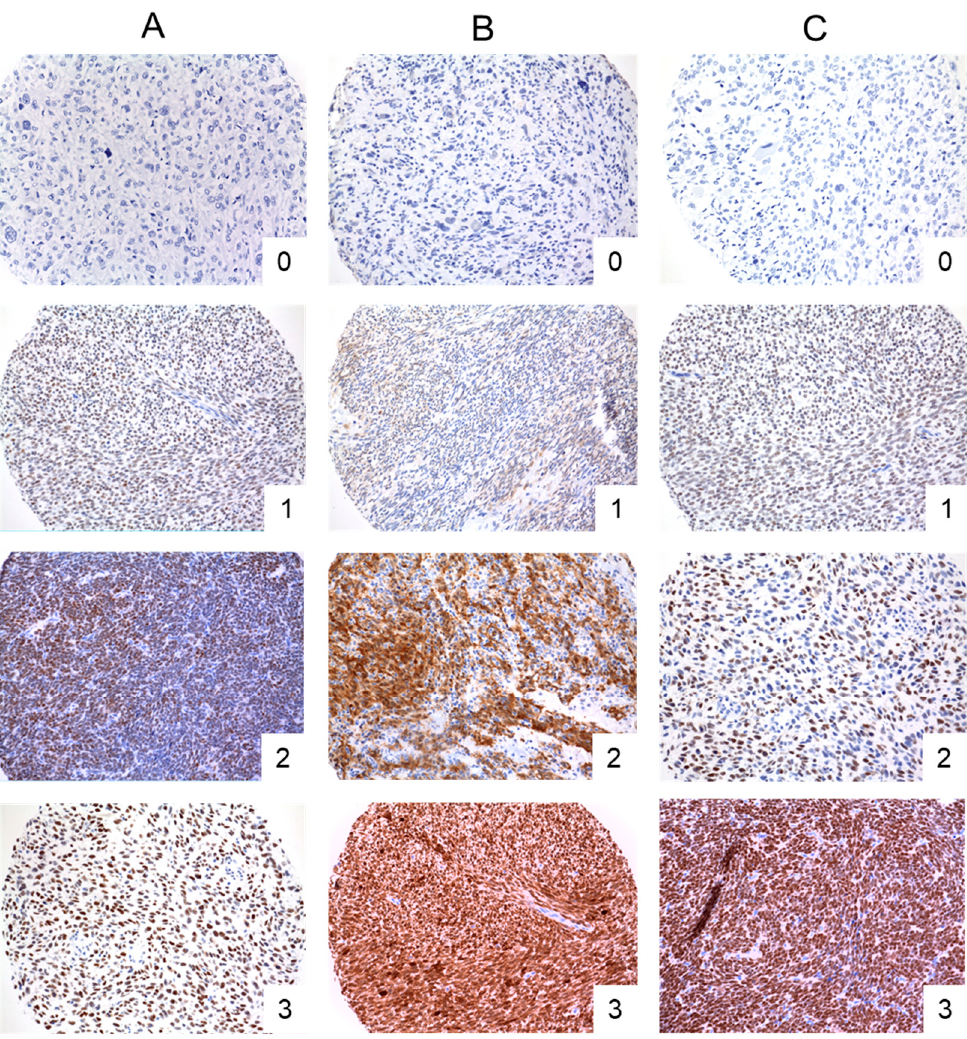
Figure 1. Representative micrographs of cores on a tissue microarray stained for ( A ) PRAME, ( B ) NY-ESO-1, and ( C ) SSX2. Numbers represent semiquantitative scoring of immunostaining: 0, negative; 1, weak; 2, moderate and 3, strongly positive. Magnification 20×. Table 2. Cancer testis antigen expression and tumour-infiltrating lymphocytes (TILs) according to tumour entity: the table shows the number and percentage of patients with high antigen expression and high TIL infiltration.